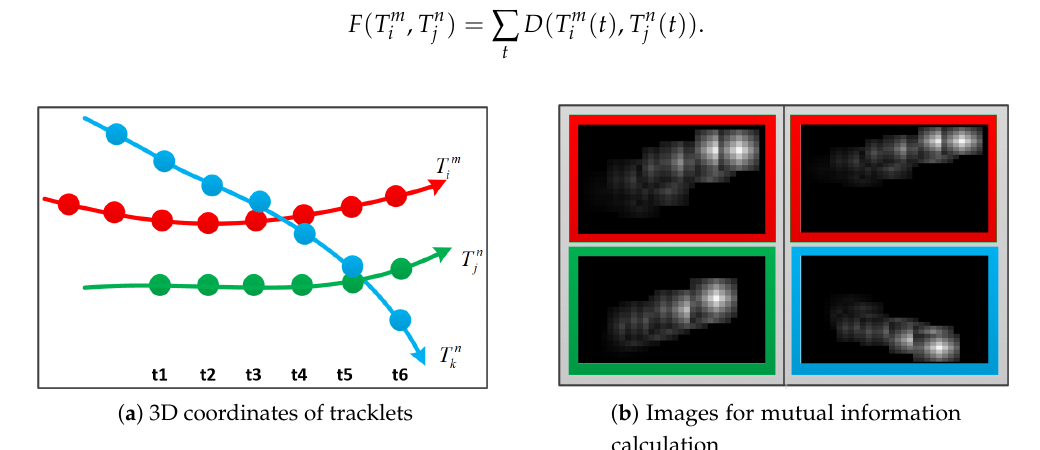
Figure 3. Calculation of tracklet spatial relationship based on image mutual information: ( a ) Illustration of the 3D trajectory projection z = 0 of three tracklets. The red tracklet T m is from view m , while i the blue and green tracklets, T n and T n , are both from view n . The left images in panel ( b ) present j k grayscale images corresponding to the two tracklets in the calculation process of the mutual information ) , while the images on the right are the images of T m MI ( T m , T n and T n i j i k